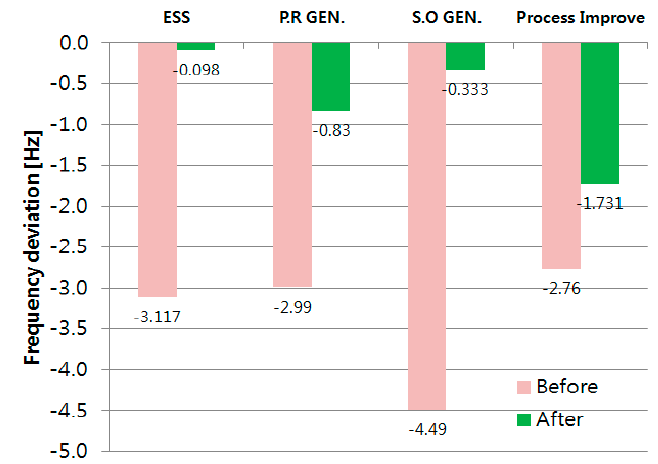
Figure 33. Comparison of simulation results.